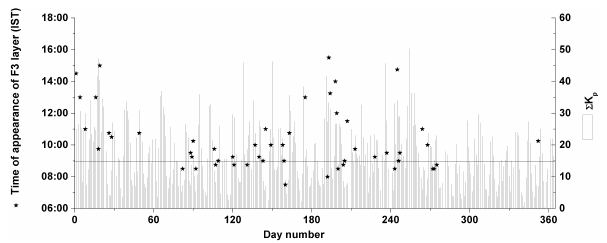
Fig. 4b. Same as for Fig. 4a, but during 2005. F3 layer was ob- served for 53